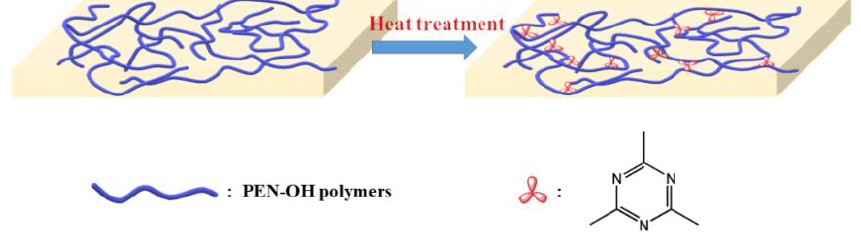
Figure 2. Diagram of the PEN–OH cross-linking reaction.